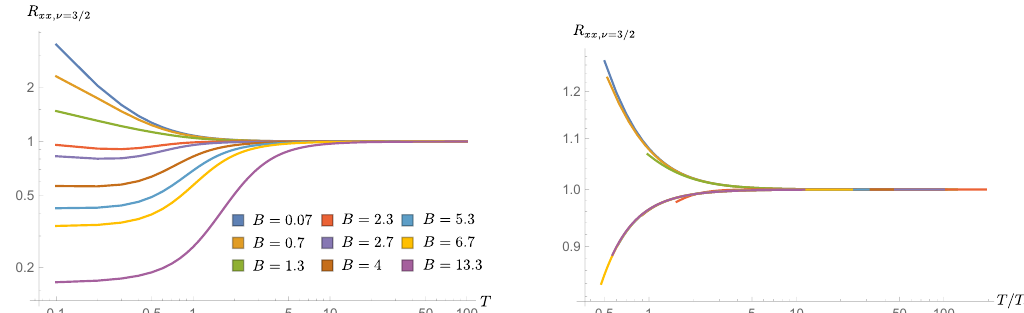
Figure 8 . Temperature dependence of the resistivity at Landau-Level (cid:12)lling factor (cid:23) = 3 = 2 for di(cid:11)erent charge densities. Left: the metal-insulator transition by dialing the magnetic (cid:12)eld B . Right: scaling of resistivity with scaled temperature T=T 0 . There exists scaling behavior for both metal and insulator in varying magnetic (cid:12)eld, or equivalently charge density, while keeping (cid:23) = (cid:26)=B (cid:12)xed. We have (cid:12)xed K = (cid:0) 1 = 6 and (cid:11) = 3.